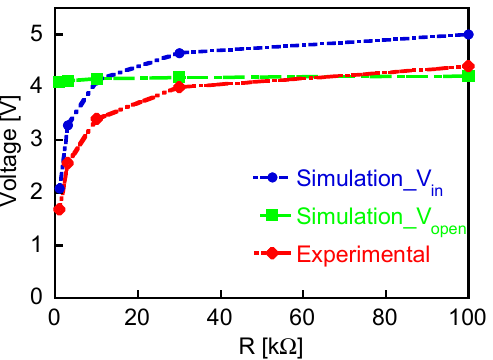
Figure 11. Peak values of experimentally measured and calculated output pulse voltages, V out , plotted as functions of load resistance, R . For simulation, (1) V in derived using MATLAB/Simulink with considered R w and L w , or (2) measured open-voltage, V open , is used as the power source of the Wiegand sensor.